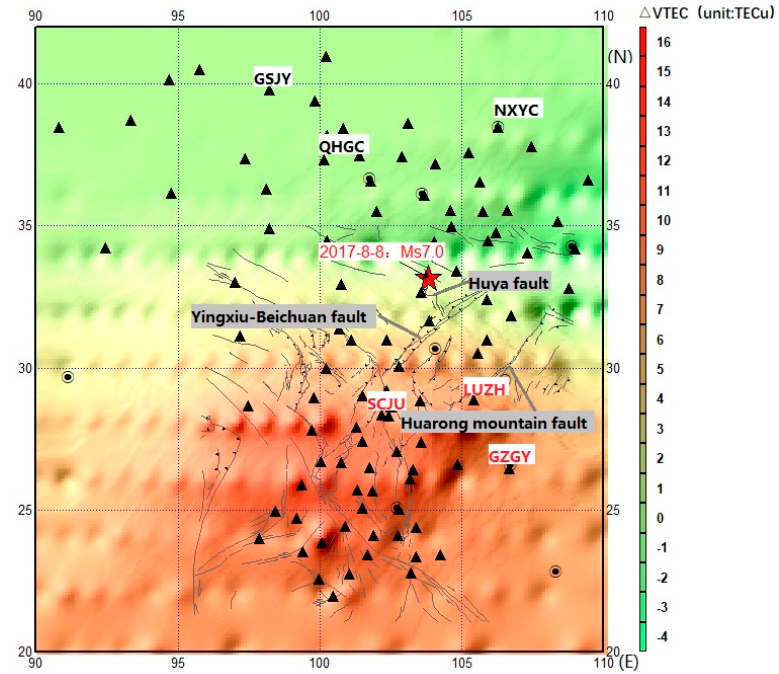
Figure 8. Spatial distribution of total electron content (TEC) anomalies on 8 August 2017. Black triangles show the locations of Global Navigation Satellite System (GNSS) base stations, and the red five-pointed star shows the epicenter location of the 2017 M w 6.5 Jiuzhaigou earthquake.